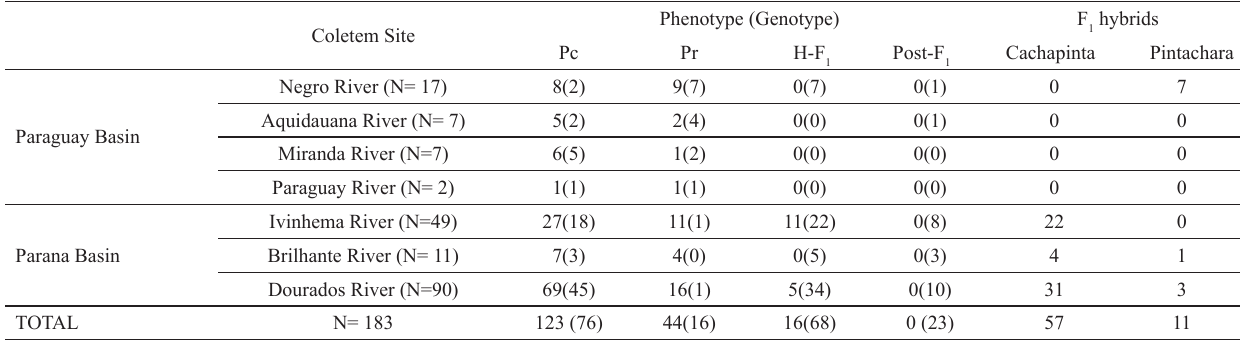
Table 3. Comparison between the phenotypic and genotypic identification of individuals at each collection site. Genotype in parenthesis, and phenotype outside parenthesis. N= number of samples; Pc= Pseudoplatystoma corruscans ; Pr= Pseudoplatystoma reticulatum ; HF = F interspecific hybrid Surubim; Post-F 1 1